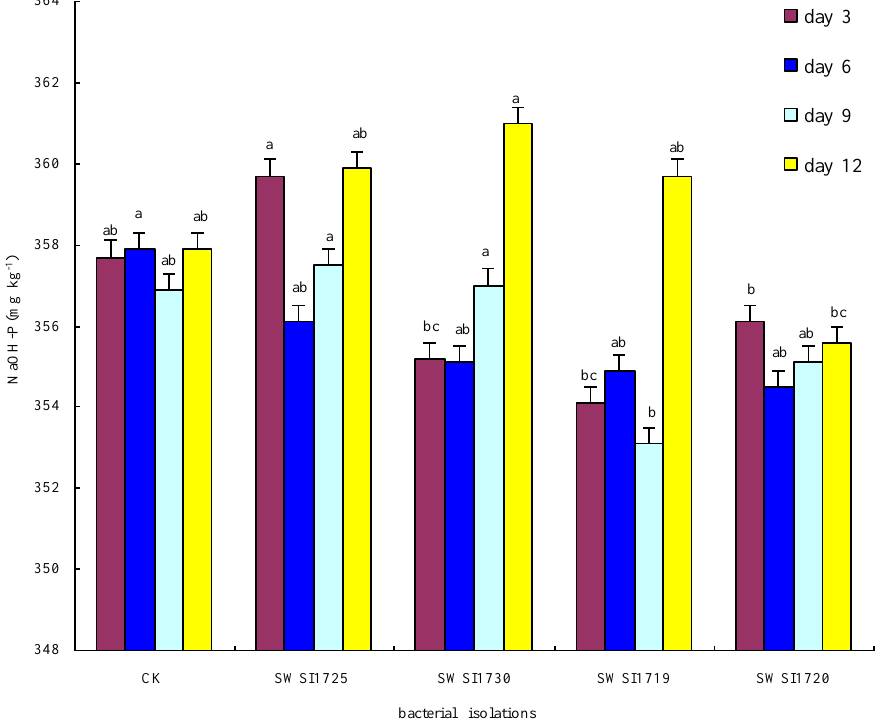
Figure 6. Comparative increases or decreases in NaOH-P by representative bacterial isolates in Sterile sediments on different incubation days. Note: The strains of SWSI1725, SWSI1730, SWSI1719, and SWSI1720 indicate the treatments inoculated. Data are means ± S.E., with the same letters on the same day of incubation among bacterial isolates denoting insignificant differences.